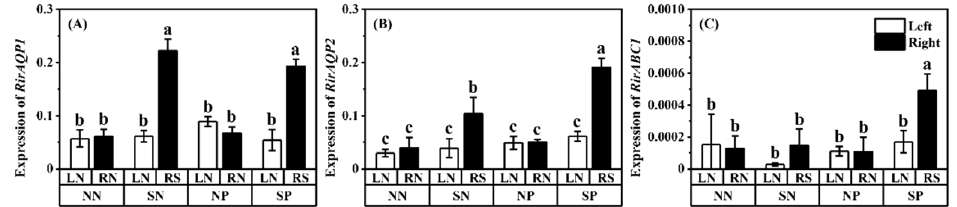
Figure 7. Expressions of RirAQP1 ( A ), RirAQP2 ( B ), and RirABC1 ( C ) in roots of M. alba . F and p -value of ANOVA are listed in Supplementary Table S3. Different letters above the columns in each graph indicate a significant difference among the means by Tukey’s test ( p < 0.05 ). The abbreviation is consistent with Figure 1.